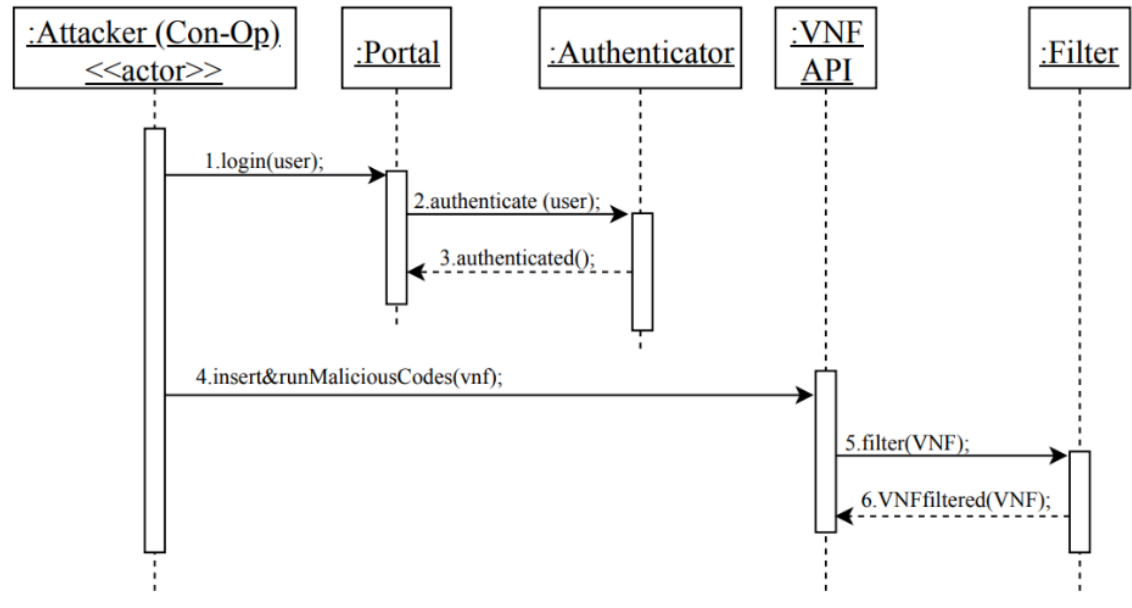
Figure 11. Sequence diagram for securely consume a network in NFV .